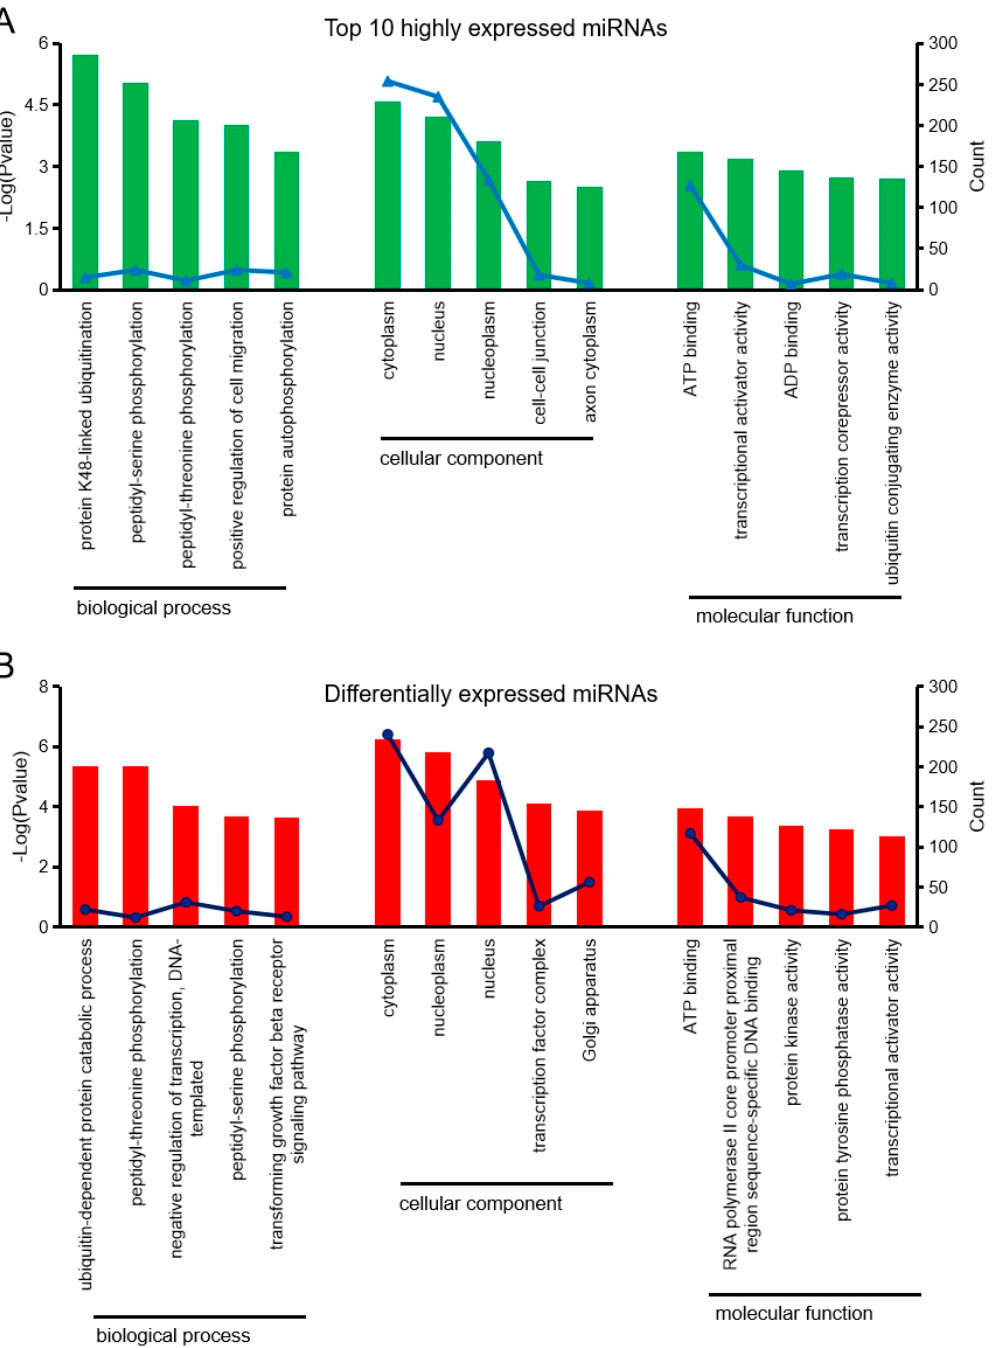
Figure 4. Partial gene ontology classification for predicted miRNAs. ( A ) Gene ontology-biological processes enrichment of target genes for top 10 highly expressed miRNAs. ( B ) Gene ontology–biological processes enrichment of target genes for differentially expressed miRNAs (RT-qPCR validated miRNAs).